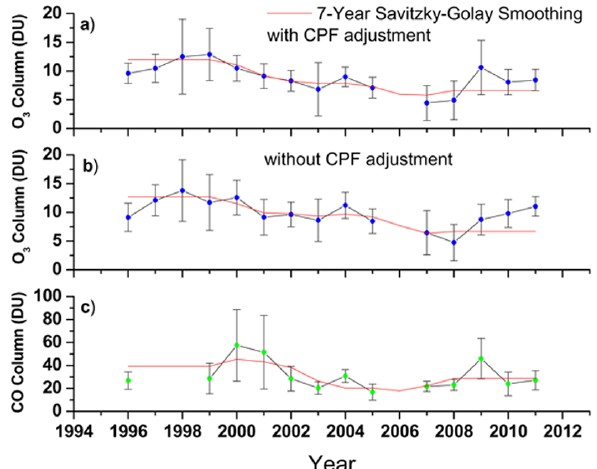
Fig. 10. Long-term trends of annual mean afternoon O 3 and CO column abundances (from the surface to 1500m AGL) over the re- gion downwind of the Baltimore/Washington area: (a) column O 3 with CPF adjustment; (b) column O 3 without CPF adjustment; (c) column CO. Error bars represent one standard deviation. The red lines are with the 7yr Savitzky–Golay